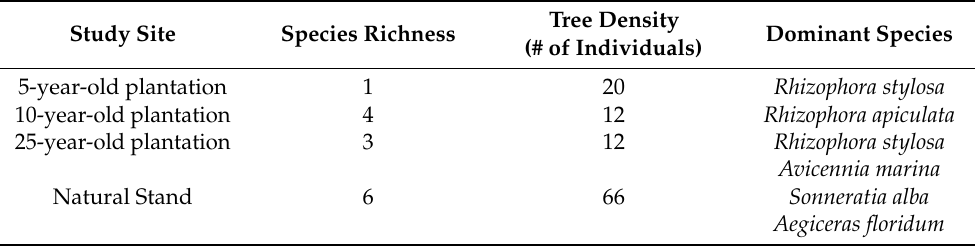
Table 1. Summary table of species richness, tree density, and dominant species per